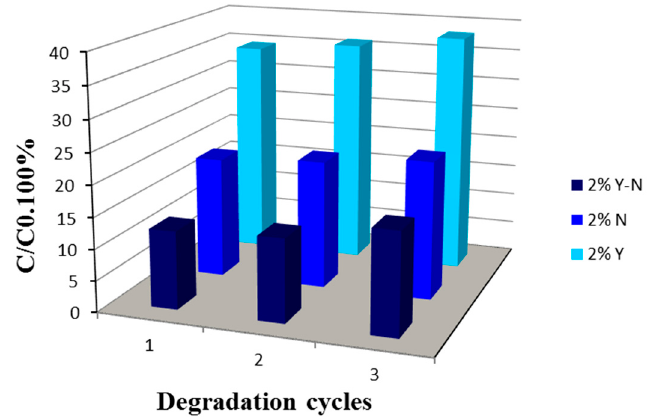
Figure 8. Evolution of the residual concentration of toluidine after three degradation cycles in the presence of 2% N, 2% Y and 2% Y-N codoped TiO 2 photocatalyst annealed at 400 °C.